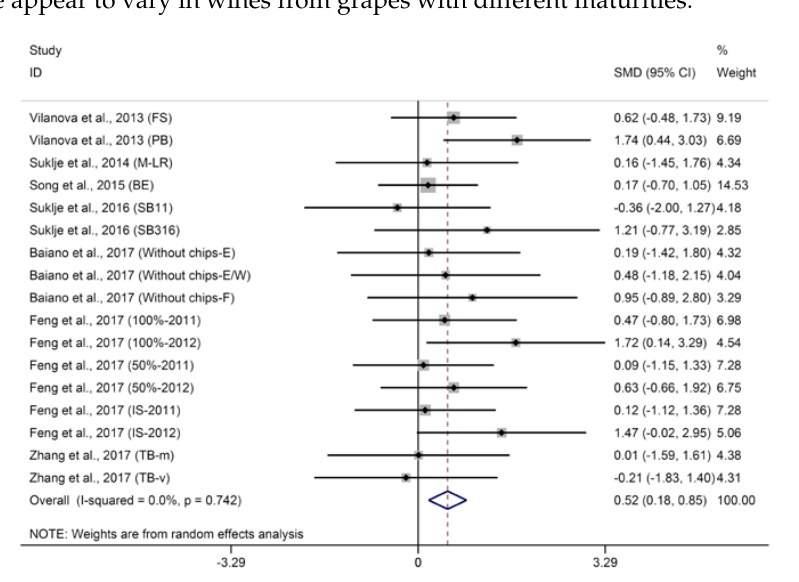
Figure 6. Meta-analysis for the effects of basal defoliation on isoamyl acetate in wine.